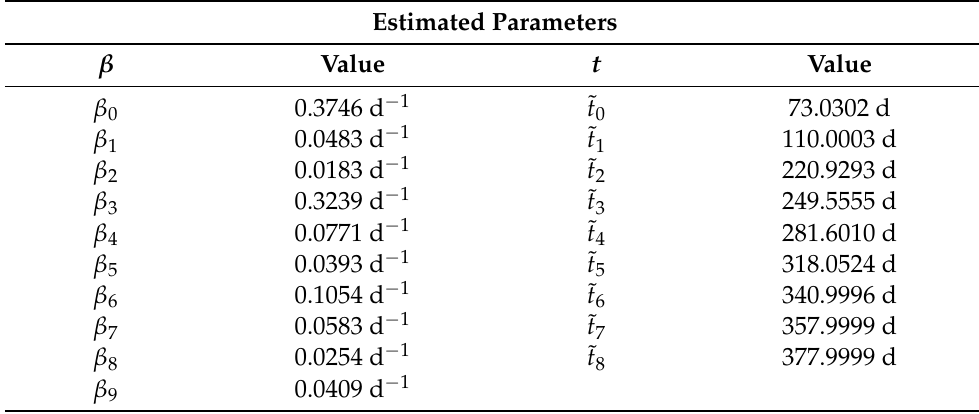
Figure 4. Comparison between SIRDV model (4) with parameters of Table 4 (continuous lines) and GBR data (dashed lines). In the inset, the curve of the deaths is magnified. Table 4. Fitting parameters for the SIRDV model (4) applied to